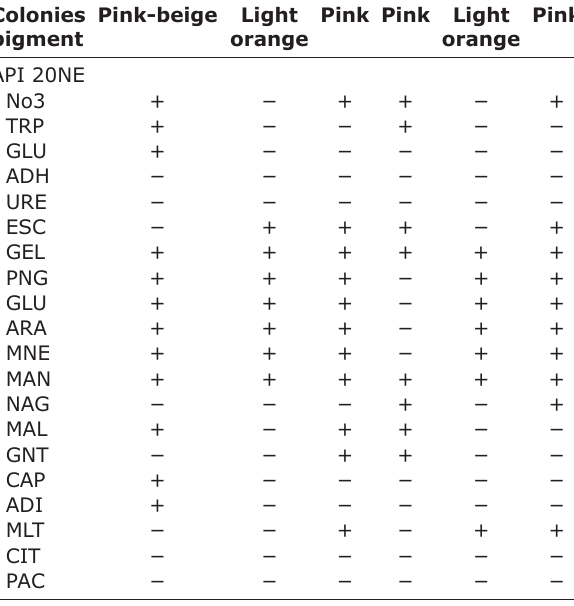
Table-2: Biochemical test on the isolates using API